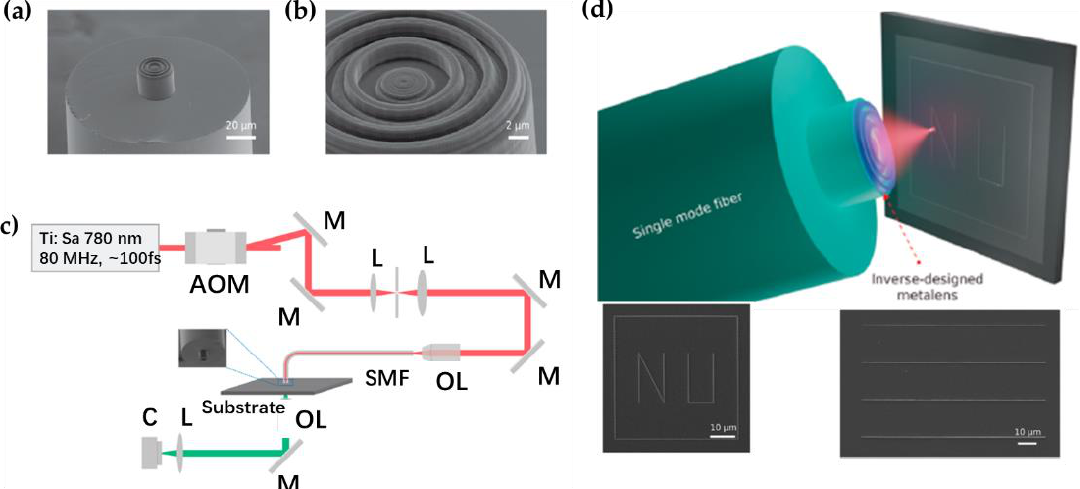
Figure 5. ( a ) SEM image of the fabricated metalens on top of the fiber core. ( b ) Enlarged view of the fiber meta-tip lens. ( c ) Schematic of the homemade two-photon laser writing system. ( d ) Illustration of two-photon writing process via fiber meta-tip lens and with the patterned “NU” and straight lines. Reprinted with permission from Ref. [54]. Copyright 2021 American Chemical Society.